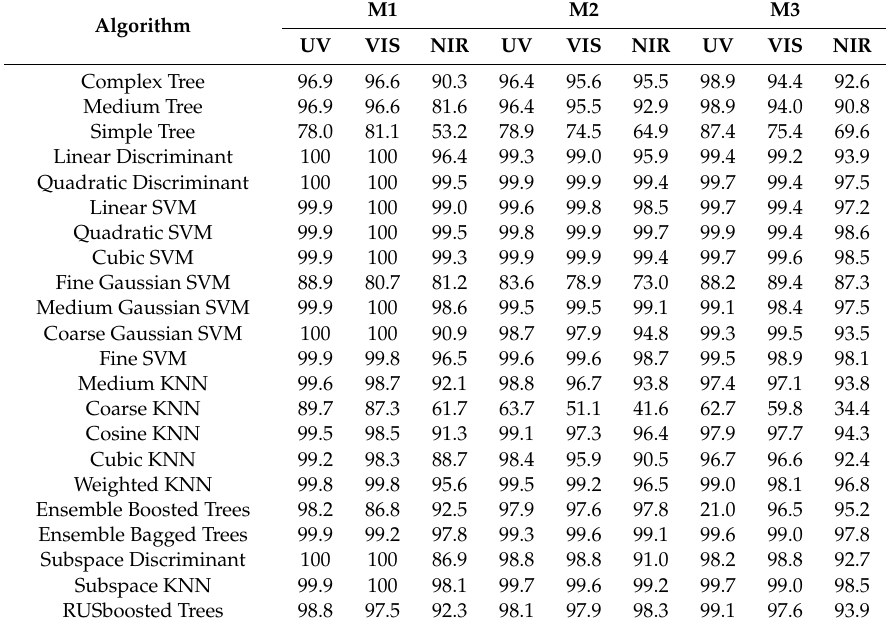
Table 2. Average prediction accuracy for 22 turn-key machine learning algorithms applied to reflectance intensity data collected using UV, VIS, and NIR spectrometers of six distinct targets and three di ff erent methods of ambient light compensation. M1 represents automatic adjustment of the integration time. M2 represents the result of M1 divided by integration time. M3 represents the result of M2 divided by ambient light energy on a wavelength basis. Bars represent average prediction accuracy.